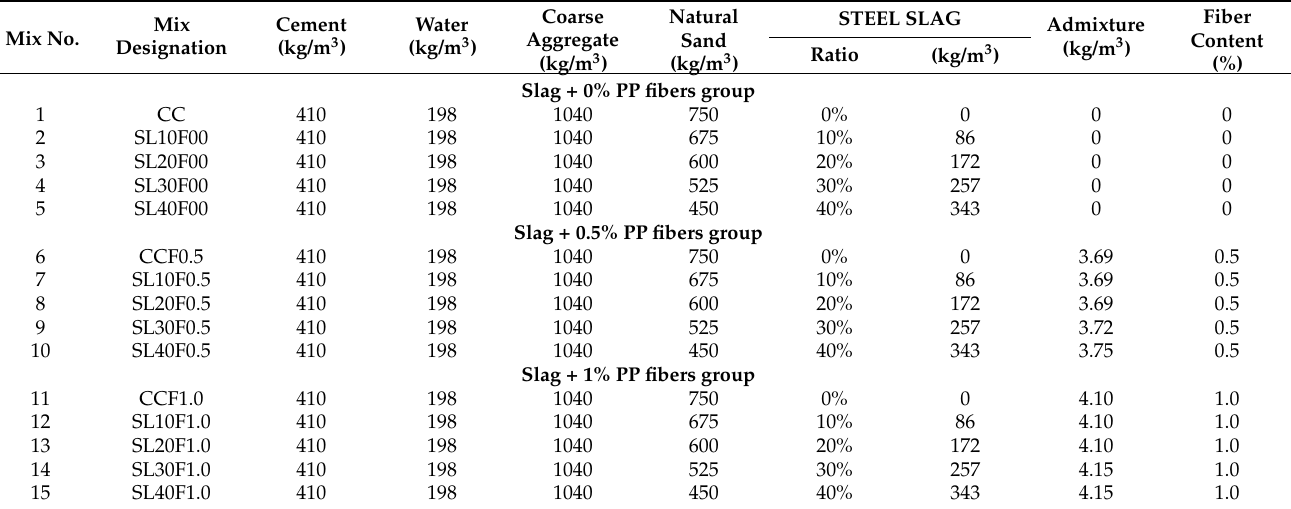
Table 5. Concrete mix proportions.